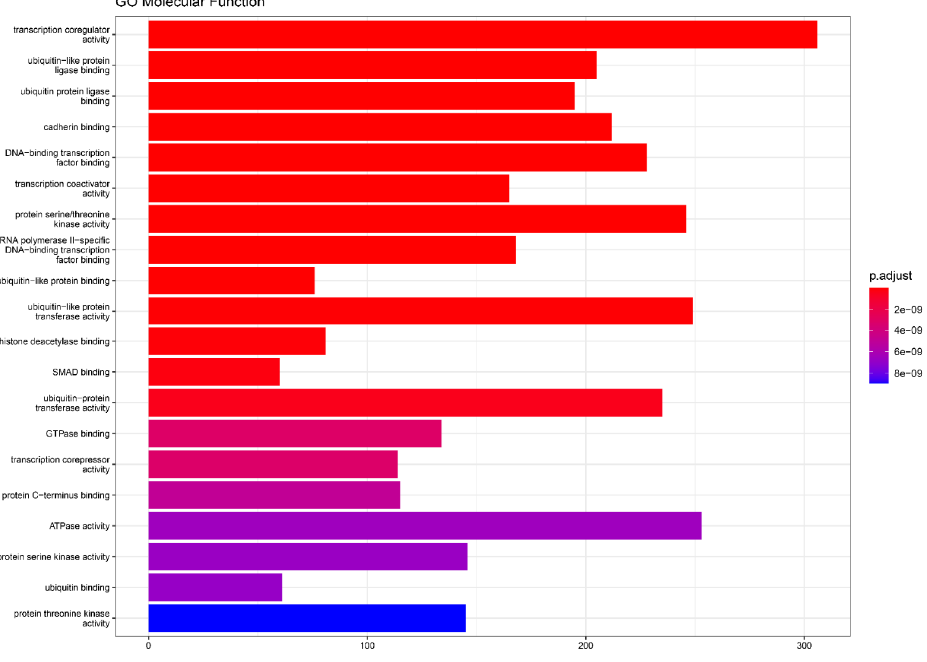
Figure 3. Top 20 GO:MF terms enriched by our top 10 miRNAs acting as important variables to our ML model.